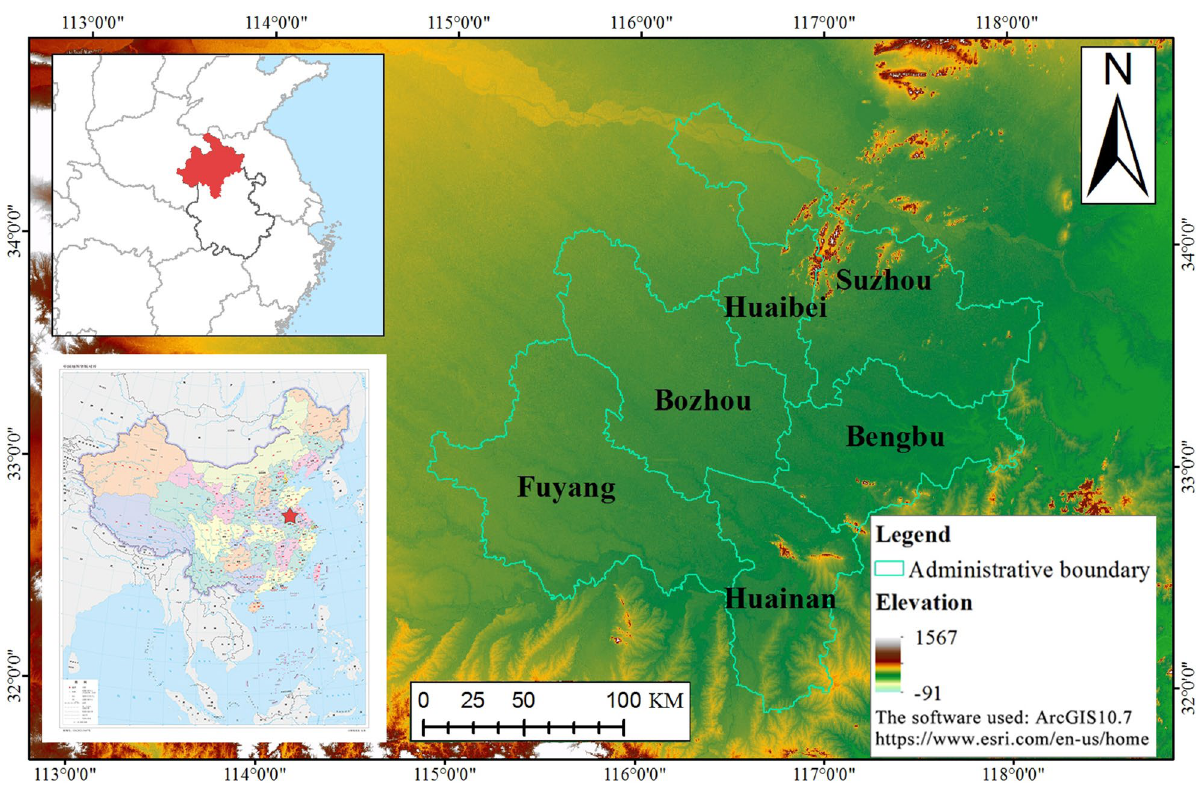
Figure 1. Schematic map of the study